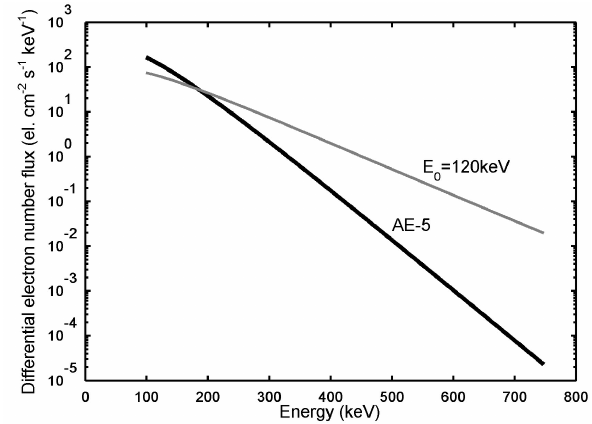
Fig. 2. Differential electron number flux of precipitated electrons in WEP events versus energy, showing the two different energy spectra used to characterize the bursts. The heavy line uses the empirical AE-5 trapped electron model, while the lighter grey line uses an e -folding energy of